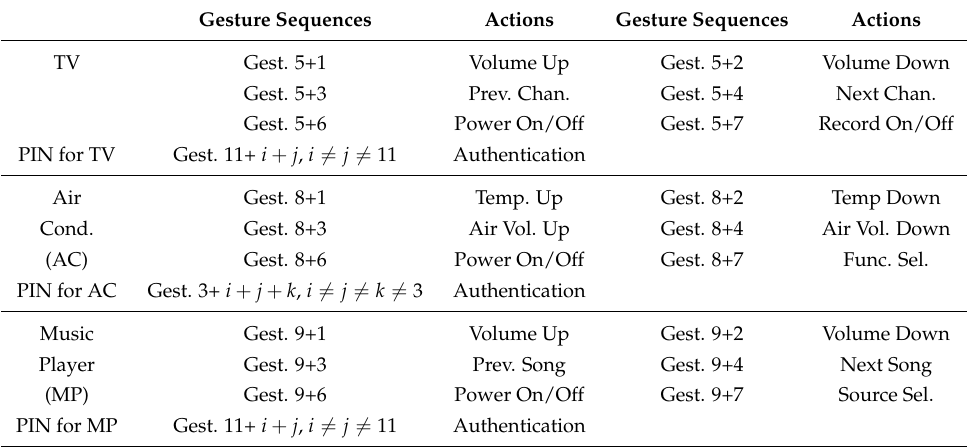
Figure 12. The eleven gesture classes considered in the smart home system in this study. Table 2. Examples of the gesture sequences and their actions for various home appliances. Each sequence of actions contains two gestures. Each sequence has a personal identification number (PIN) for home appliances’ authentication contains three or four gestures. The definition of gestures are shown in Figure